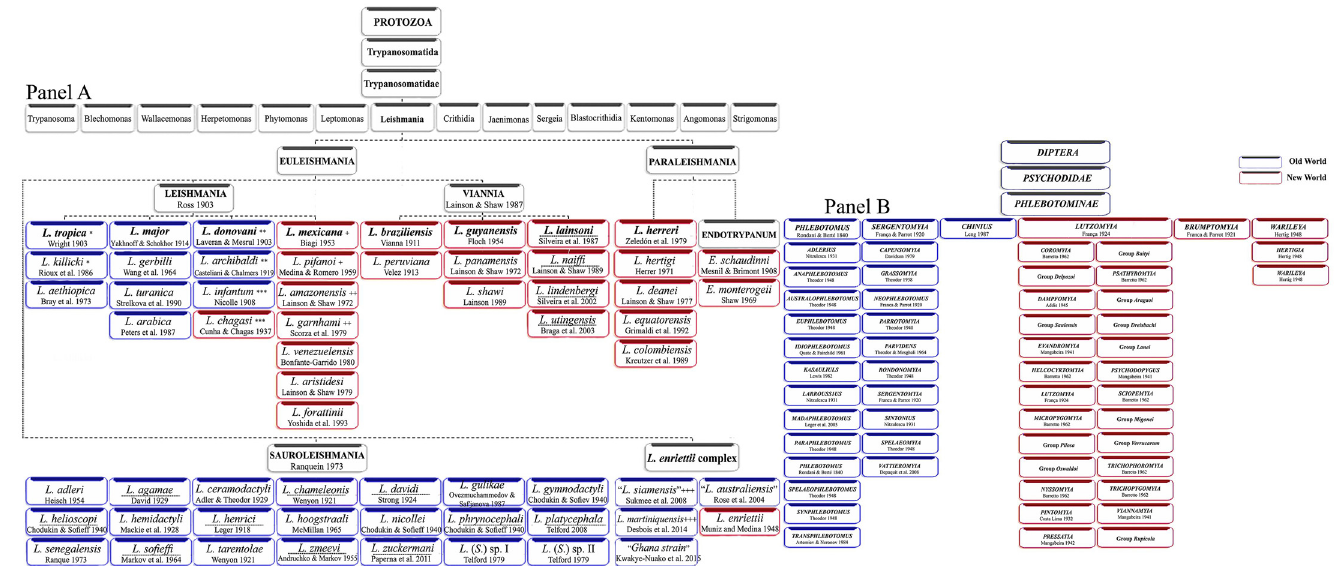
Fig 1. Updated classification of Leishmania and sandfly. Panel A. Classification of Leishmania species. * , +: Synonym; different numbers of star ( * ) and plus (+) signs mean which species name is the synonym for which original species, Underlined: No final classification. @ L. siamensis @ and L. martiniquensishave been found also in the New World. Leishmania names in quotationmark are unofficial names without formal descriptions. Panel B. Phlebotominae sandfly classification,according to Theodor [6,13], Quate and Fairchild [163], Theodor and Mesghali[22], Lewis [5], Leng [15], and Young and Duncan